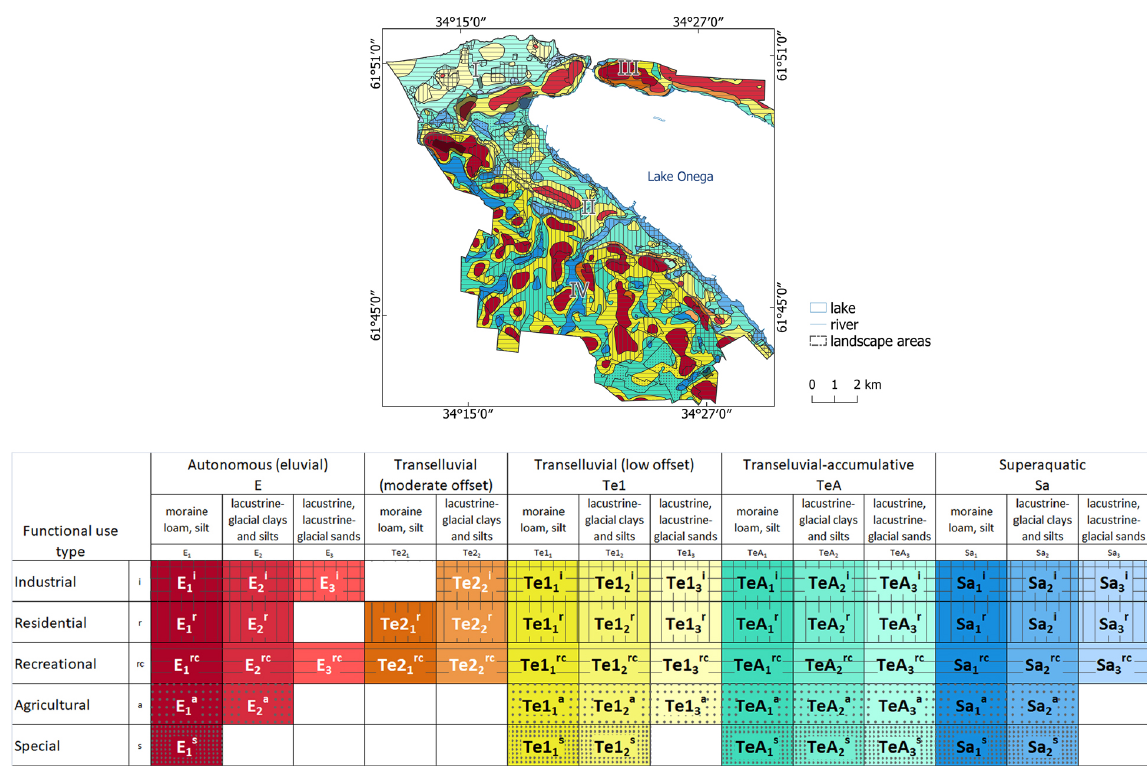
Fig. 12. Landscape model of Petrozavodsk.